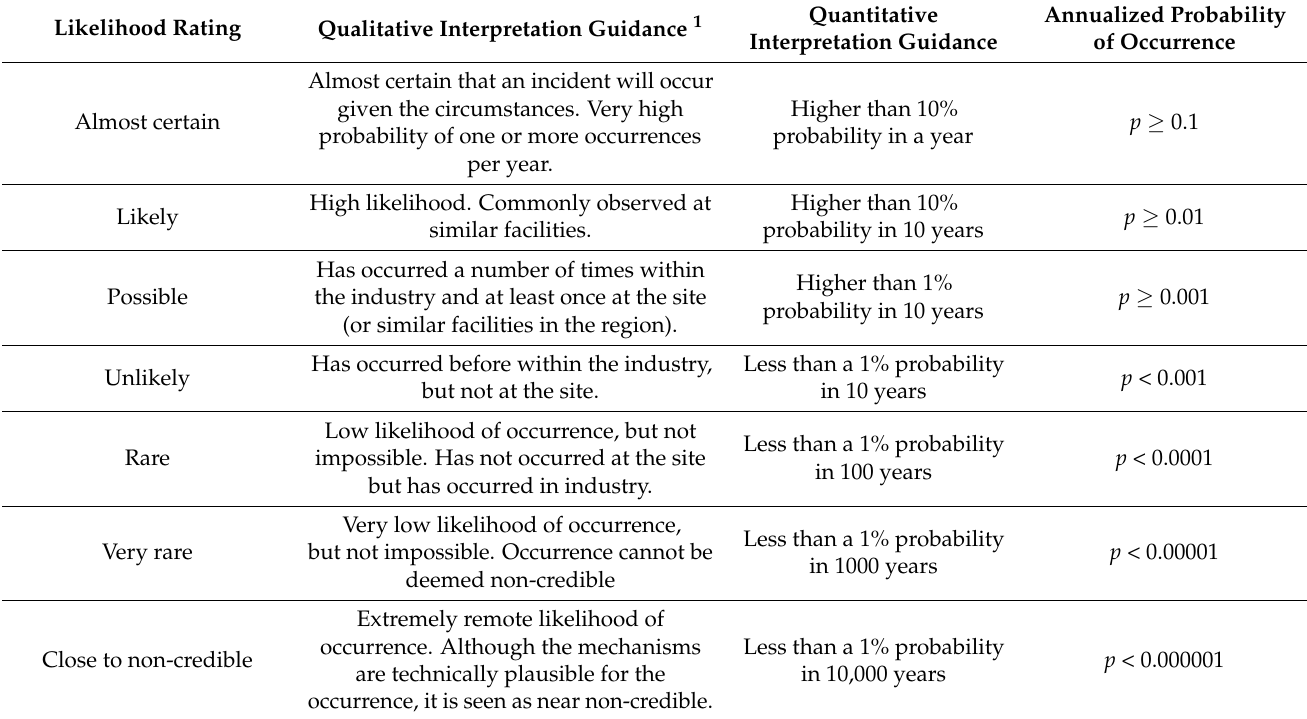
Table 5. Likelihood